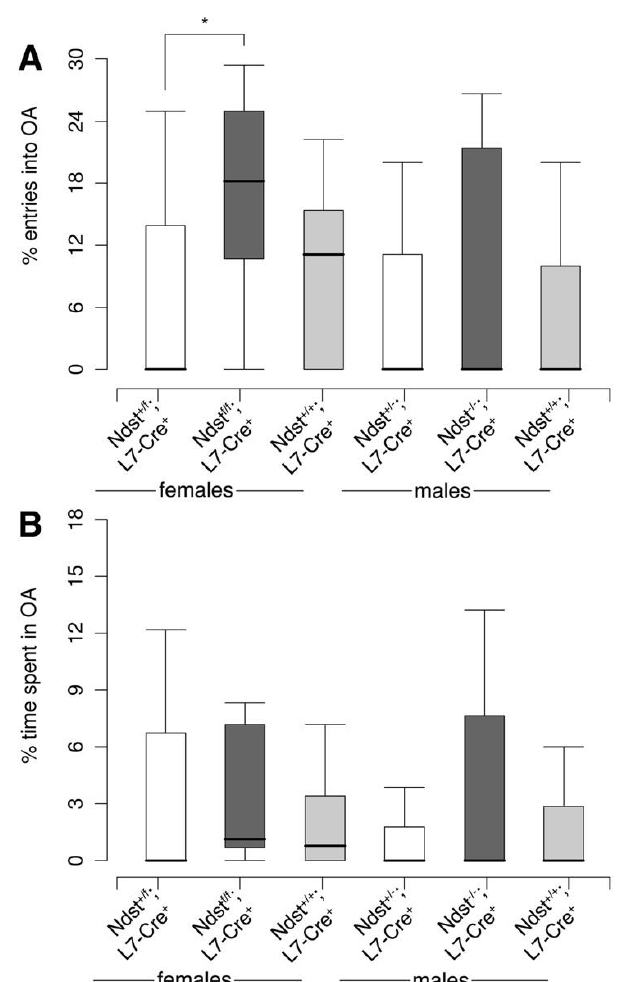
Figure 7. Elevated plus maze. ( A ) Percentage of entries into the open arms. Exact Wilcoxon rank sum